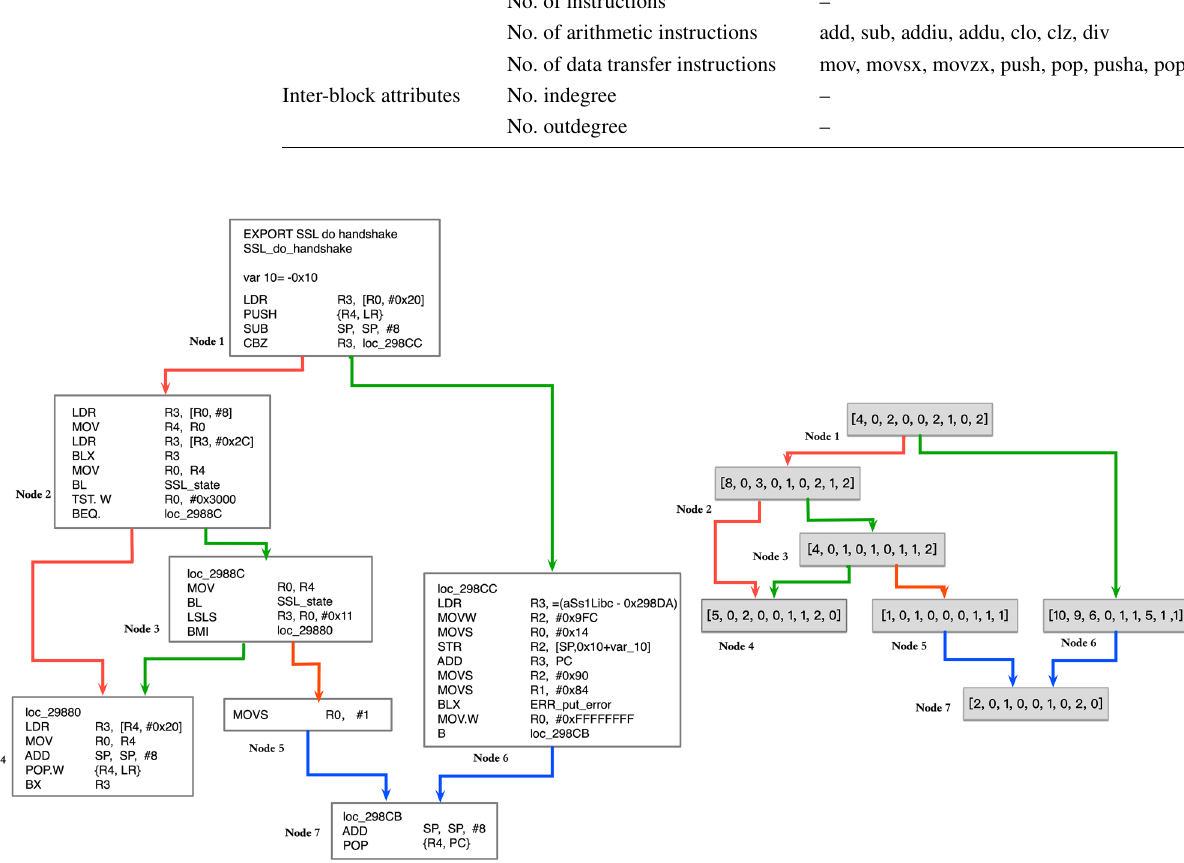
Fig. 3 Attributed CFG of function SSL _ do _ handshake on ARM